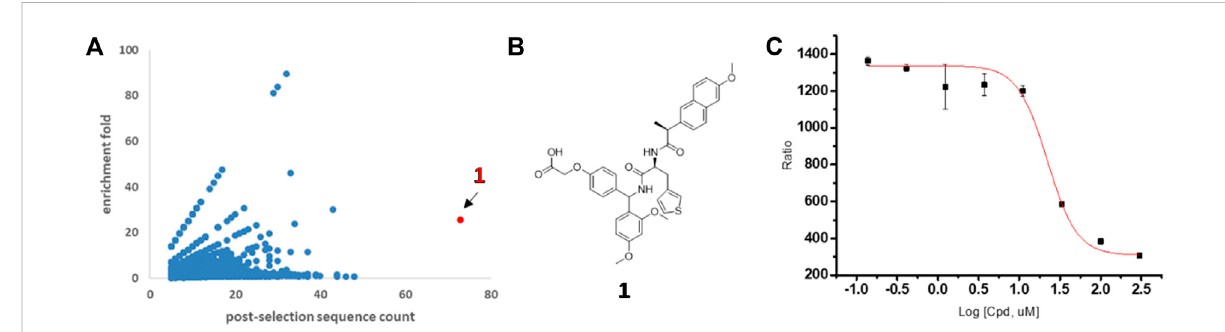
FIGURE 2 Discovery of novel TIGIT ligands by DEL screening. (A) Two-dimensional display of post-selection DNA sequencing data from TIGIT selection. x -axis: post-selection sequence counts; y -axis: post-selection enrichment fold = (post-selection counts %)/(pre-selection counts %). (B) Structure of hit 1 . (C) Blocking effects on TIGIT/CD155 complex in HTRF assay for hit 1